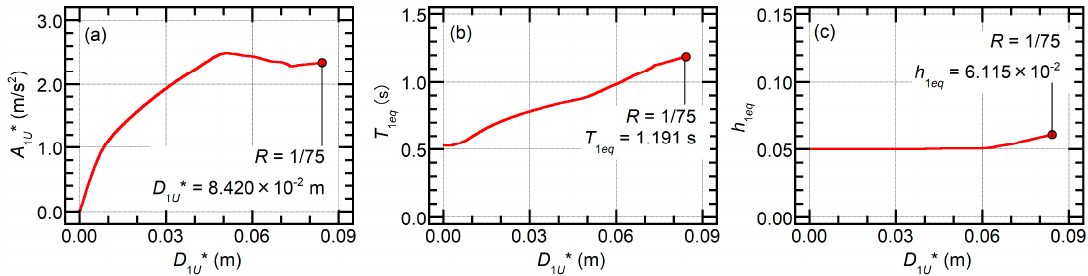
Figure 15. Nonlinear properties of the equivalent SDOF model representing the first mode response obtained from the pushover analysis: ( a ) A 1 U * - D 1 U * relationship, ( b ) T 1 eq - D 1 U * relationship, and ( c ) h 1 eq - D 1 U * relationship.